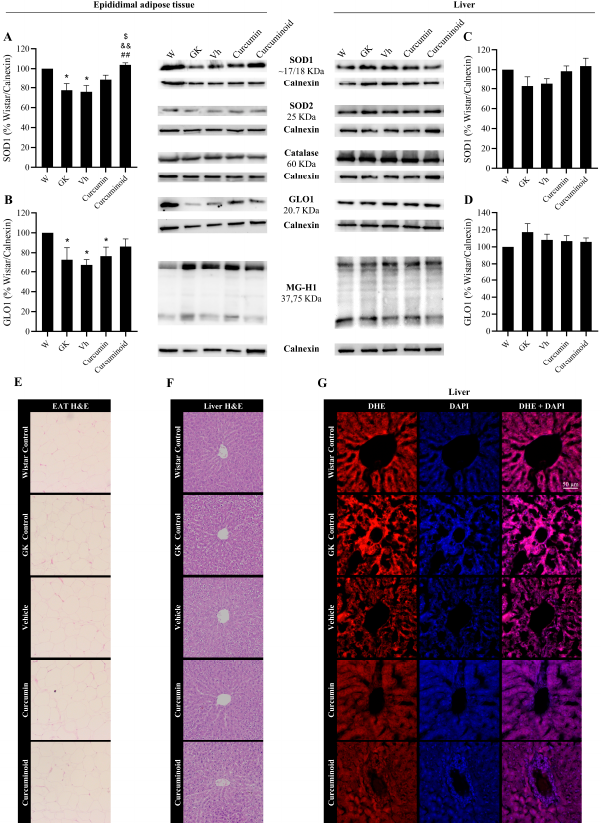
Figure 5. Improved levels of SOD1 ( A ) and GLO1 ( B ) in epididymal adipose tissue, calculated as percentage of Wistar control/Calnexin, evaluated by WB after the treatment with the curcuminoid; representative WB is shown. SOD1 ( C ) and GLO1 ( D ) levels were also evaluated in liver by WB; representative WB is shown. Histological analysis shows hematoxylin–eosin (H&E) staining in EAT ( E ) and liver ( F ). Representative liver sections show the staining (red) of the superoxide-sensitive DHE dye ( G ). W:Wistar control; GK: Goto-Kakizaki control; Vh: Goto-Kakizaki submitted to vehicle (DMSO)